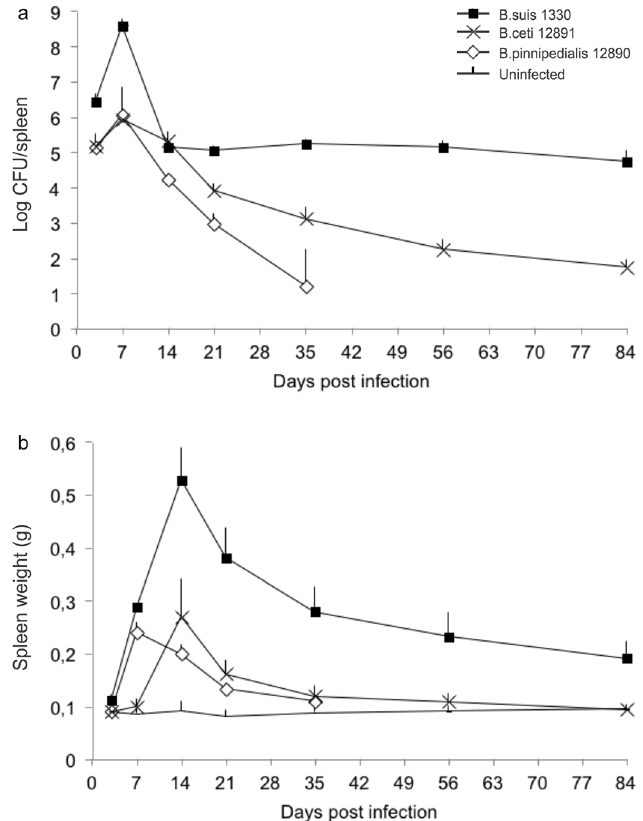
Fig 1. Spleen bacterial counts and organ weights. Bacterial counts for B. pinnipedialis 12890 (open diamonds), B . ceti 12891 (crosses) and B . suis 1330 (black squares) in spleens (a) of BALB/c mice after intraperitoneal (ip) inoculation of 10 5 colony forming units (CFU) of bacteria. Uninfected control mice received sterile phosphate buffered saline ip (black lines). Four or five mice were euthanized per lot at day 3, 7, 14, 21, 35, 56 and 84 post infection (day 56 and 84; only B . ceti 12891 and B . suis 1330). The number of viable bacteria was determined and the numbers of bacterial counts were logarithmic transformed. Spleen weights (b) were determined in parallel. Results are expressed as mean + one standard deviation. Whether CFU numbers differed significantly between mice infected with B . suis 1330, and B . ceti 12891 or B . pinnipedialis 12890, respectively, at the different times pi, are presented in Table 1. Whether spleen weights of the infected mice were significantly different from those of the uninfected control mice, at the different times pi, is presented in S1